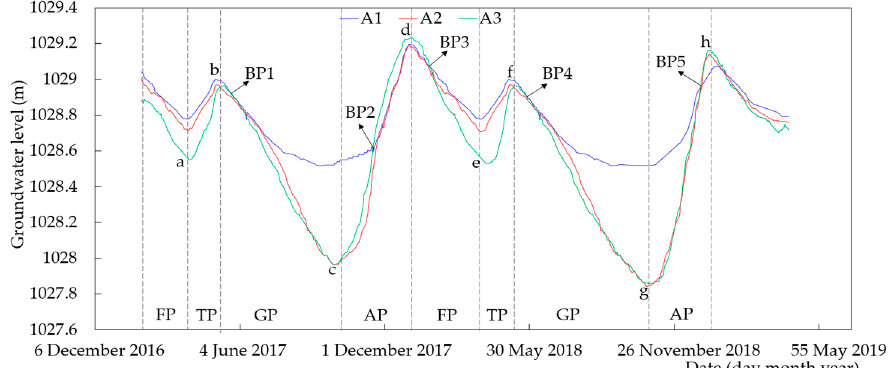
Figure 6. Groundwater-level dynamics in different periods from 2017 to 2018. Freezing period (FP), thawing period (TP), growing period (GP), autumn-irrigation period (AP); Balance Point 1 (BP1),